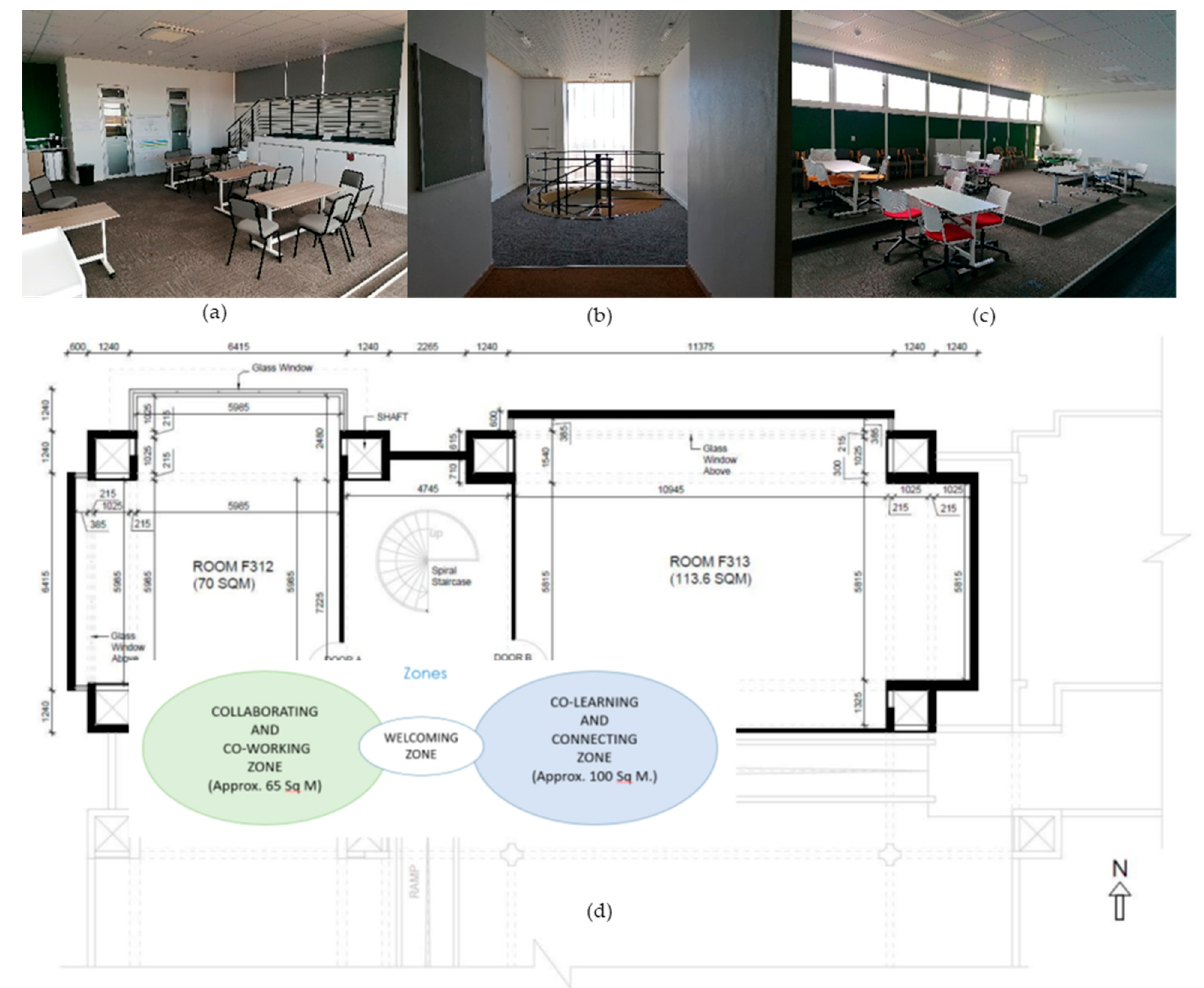
Figure 4. Case 2 working area divided into several zones with different activities. ( a ) Collaborating and Co-working zone; ( b ) Welcoming zone; ( c ) Co-learning and connecting zone; ( d ) floorplan in the starting point, where the unit of length is in millimeters.